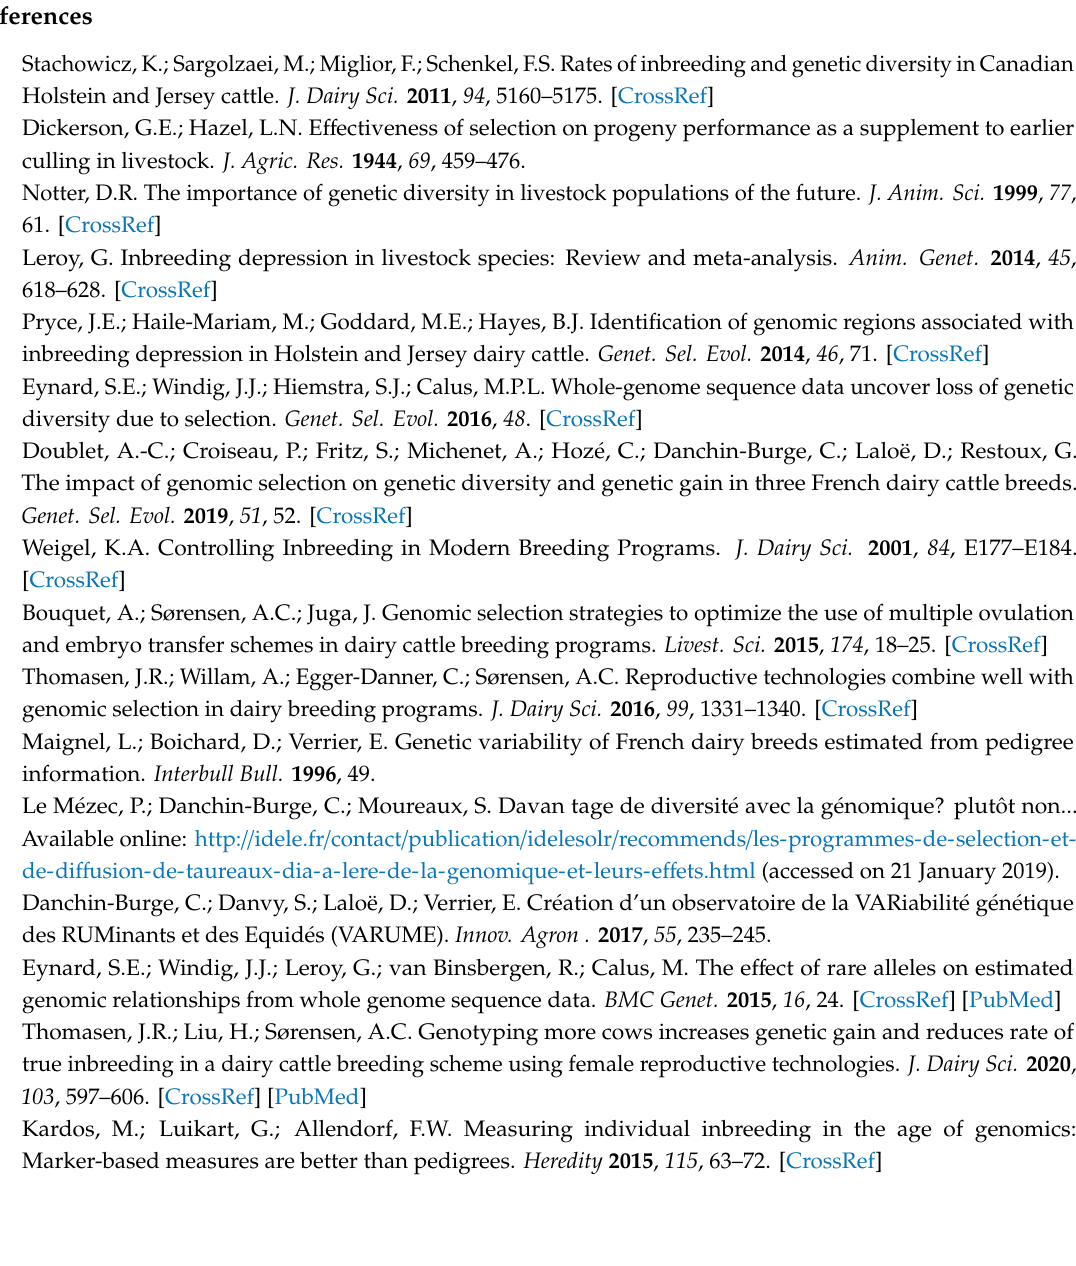
Table S1: Positions and e ff ects of additive quantitative trait loci (QTLs) along the simulated genome used as the basis for simulations of an embryo transfer breeding scheme and variations thereof in French dairy cattle breeds, Table S2: ROH-based inbreeding rates per generation and genetic gains in true breeding value per generation for each scenario of the simulated embryo transfer breeding program in French dairy cattle, Figure S1: Proportion of female donors and of sires and bulls born from embryo transfer over all birth years and replicates for each scenario of the simulated embryo transfer breeding scheme in French dairy cattle